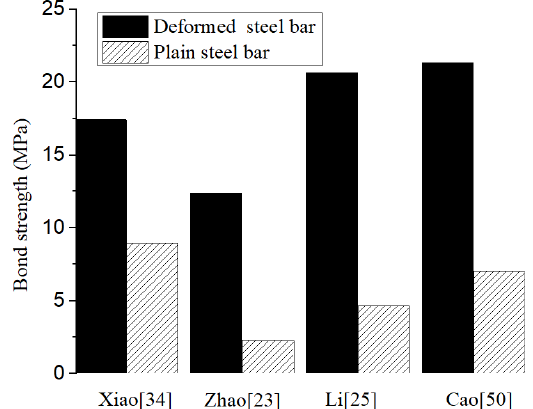
Figure 7: Bond strength versus steel bar type.